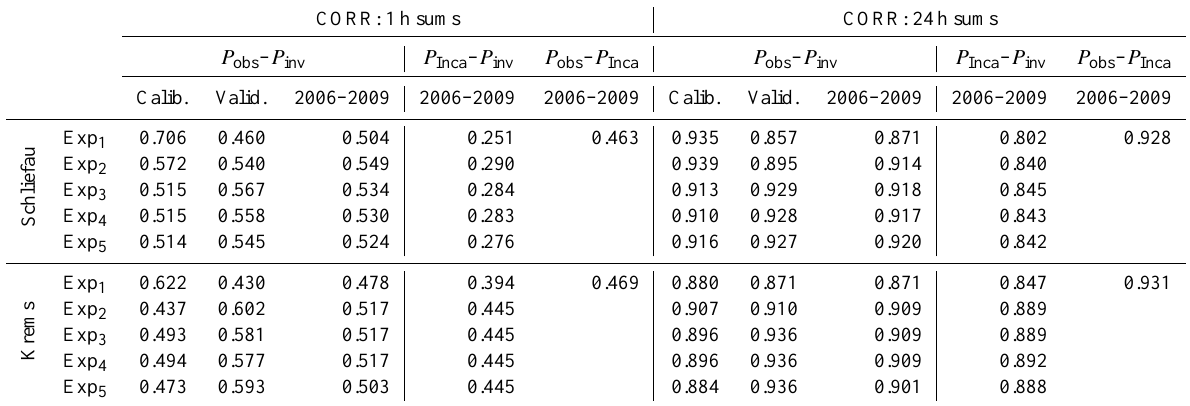
Table 8. Correlation between different rainfall realisations, evaluated for different periods and for 1h and 24h sums. ( P obs : ground observa- tion, P inv : inverse rainfall from Exp 1 to Exp 5 , P Inca : INCA rainfall). CORR: 1h